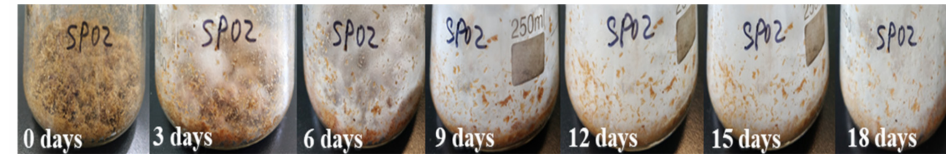
Figure 9. Cultural characteristics of C. unicolor SP02 in corn stalk